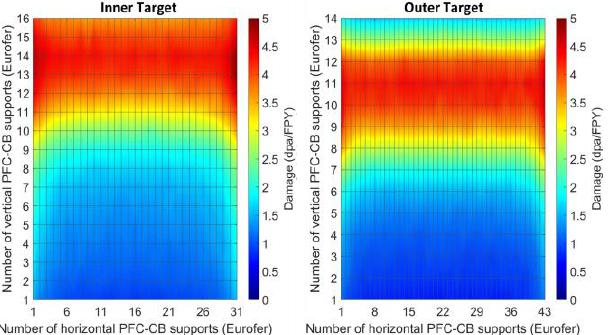
Figure 21. Nuclear damage (dpa/FPY) distribution on PFC-CB supports (Eurofer) of the inner ( left ) and outer ( right ) target, with WCLL blanket.